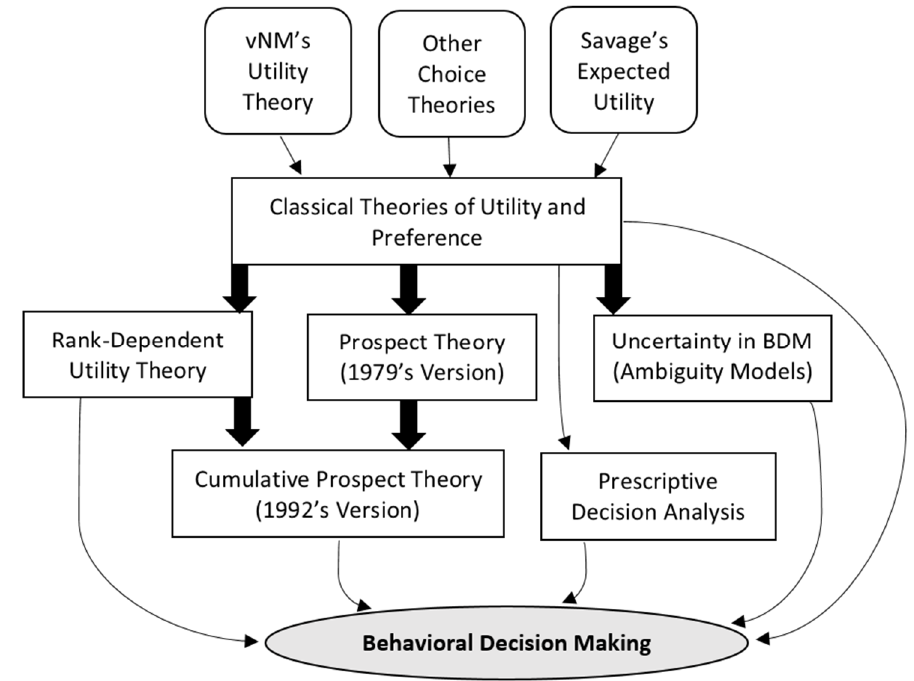
Figure 1. The relational graph of past theoretical branches to the modern BDM.